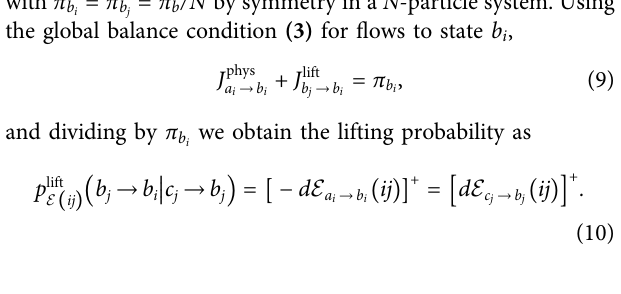
Frontiers in Physics |